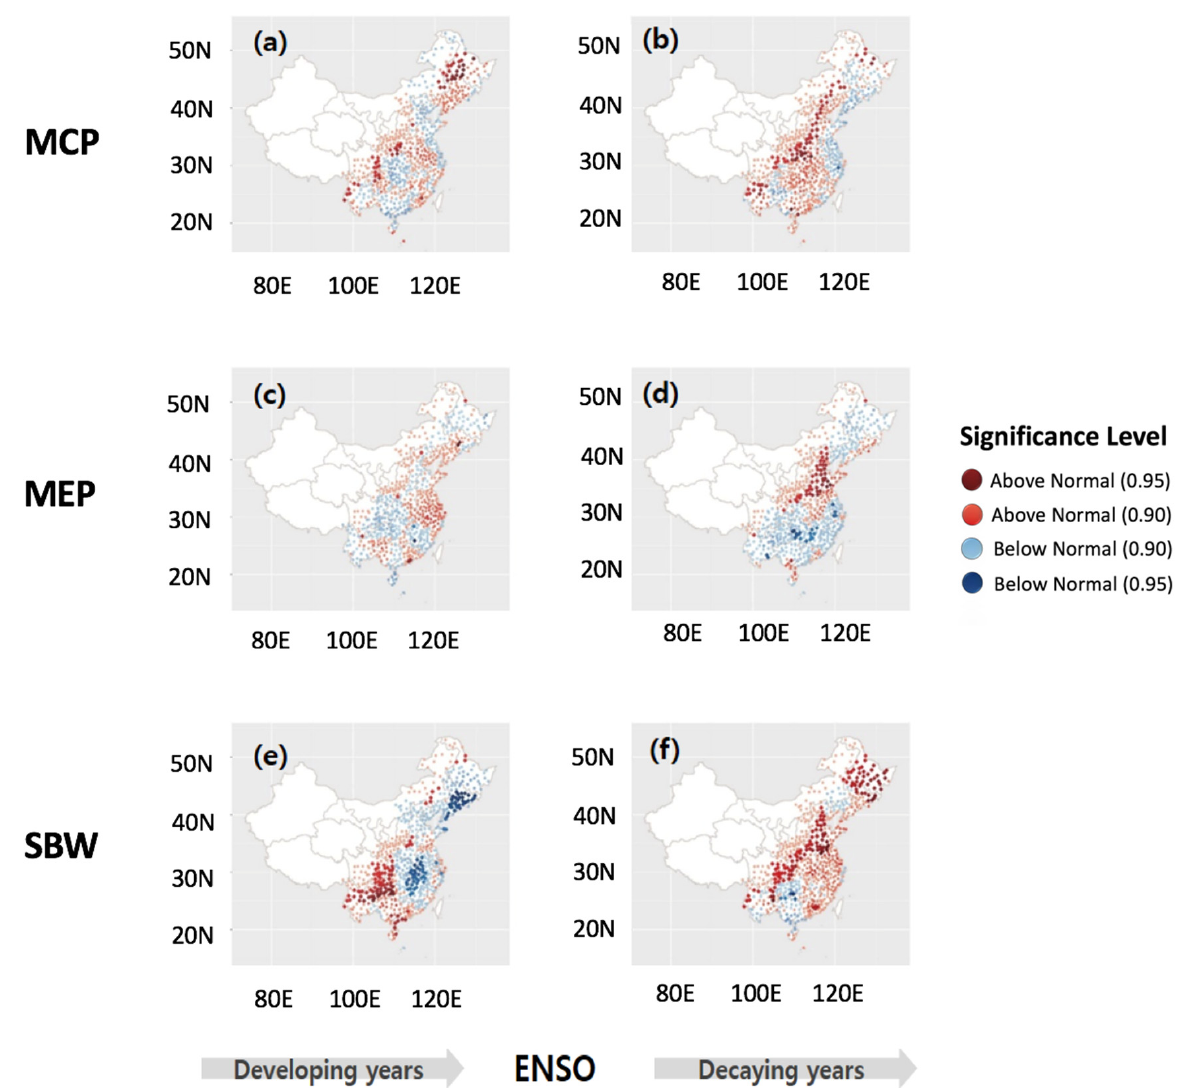
Figure 8. Composite consecutive tropical cyclone-induced precipitation days (CTPD) anomalies compared to long-term averages. The red dots indicate above normal results, whereas the blue dots indicate below normal results. The light- (dark-)colored shaded indicates change at a 90% (95%) significance level. MCP: moderate central Pacific, MEP: moderate eastern Pacific, SBW: strong basin-wide. ( a , b ) moderate central Pacific (MCP); ( c , d ) moderate eastern Pacific (MEP); ( e , f ) strong basin-wide (SBW).